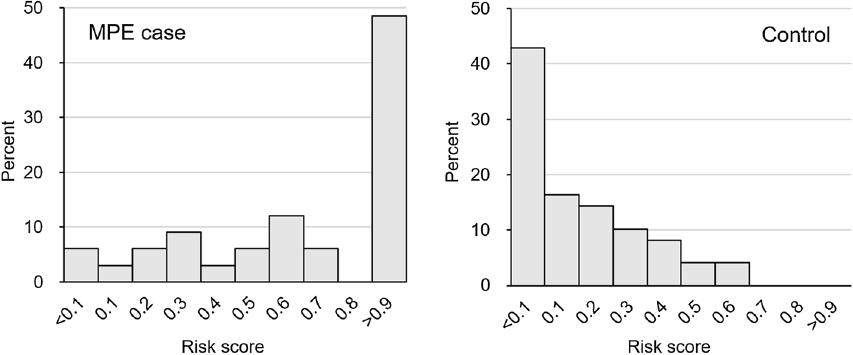
Figure 2. Histogram of risk score of samples (in